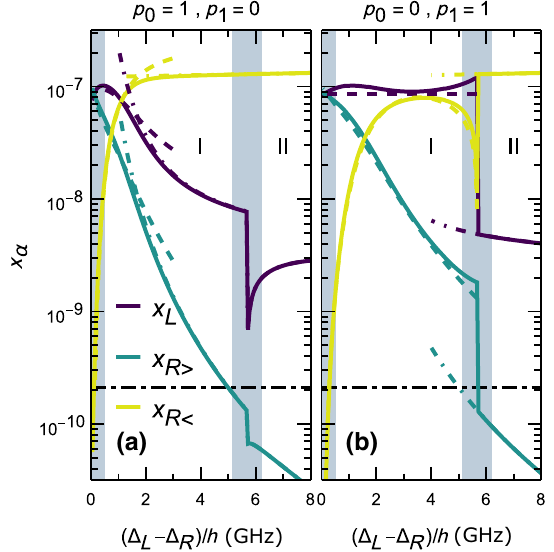
FIG. 7. Quasiparticle densities in the steady state versus the gap difference ((cid:2) L − (cid:2) R )/ h for a qubit stabilized in (a) the ground state ( p 1 = 0) or (b) the excited state ( p 1 = 1). Each hor- izontal dotted-dashed line identifies the density corresponding to a single quasiparticle. Parameters: (cid:2) L / h = 52 GHz, ω 10 /( 2 π) = 5.7 GHz, E J / h = 15.5 GHz, E C / h = 290 MHz, (cid:12) ph = 10 Hz, T qp = 20 mK, V L = V R = 940 μ m 3 , r L = r R < = ( 160 ns ) − 1 , and = 0.73 × 10 47 J − 1 m − 3 . Dashed and dot-dashed curves in (a) ν 0 are obtained as in Fig. 6(a). In (b), the dashed (dot-dashed) curves are given by Eqs. (33)–(35) [(28), (36)–(37)].